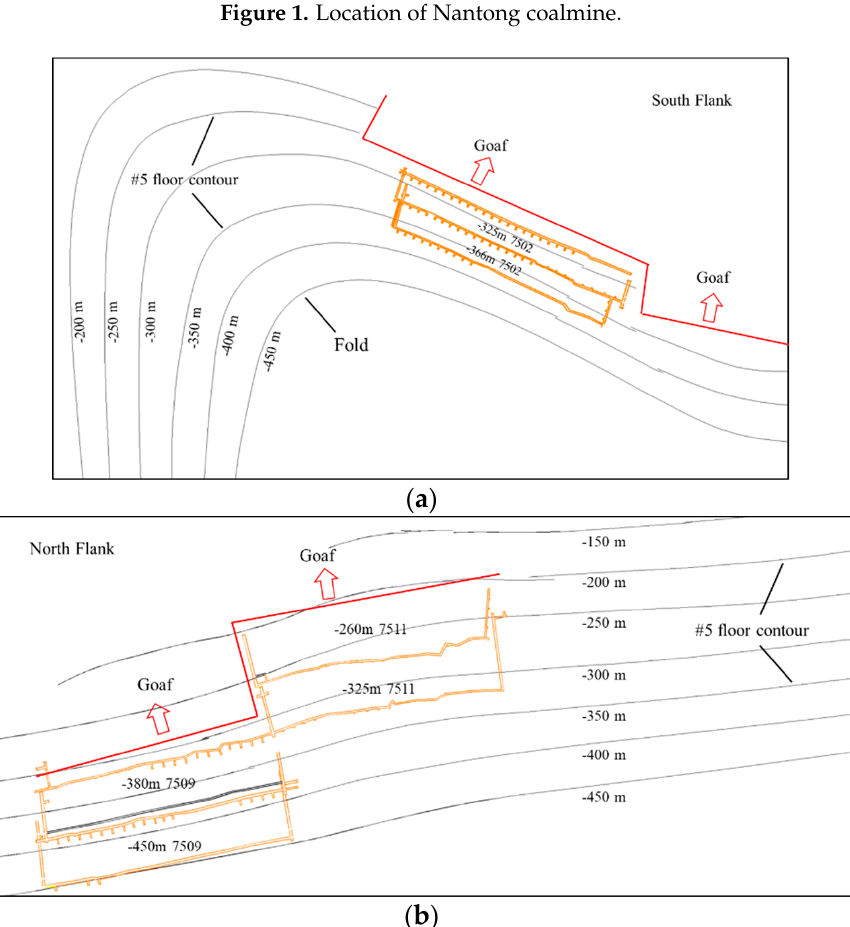
Figure 2. Floor contour of the #5 coal seam. ( a ) South flank; ( b ) North flank.